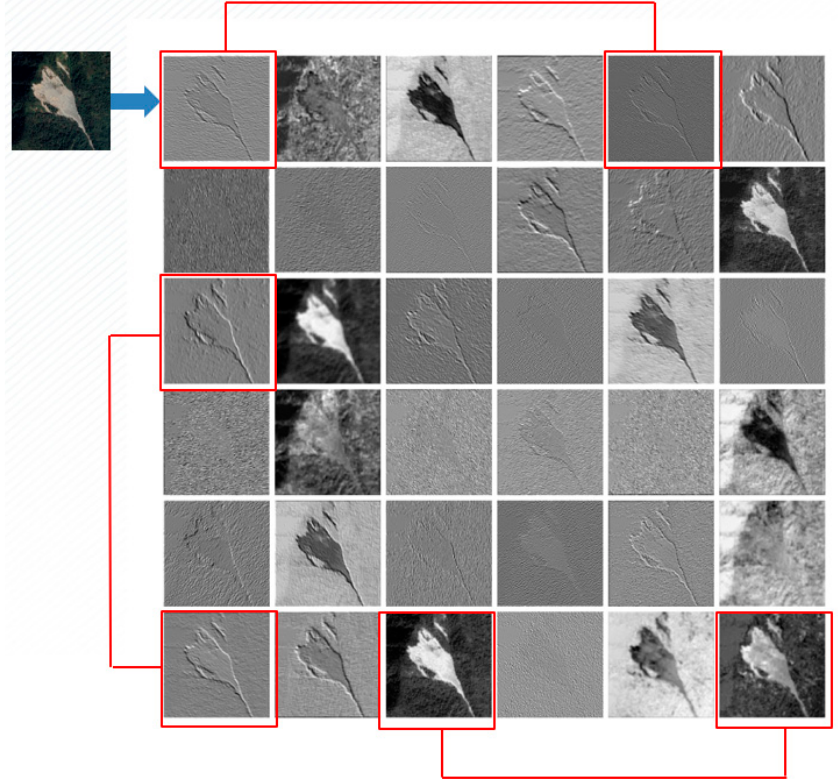
Figure 7. The connected pairs of feature maps marked in this figure are very similar.